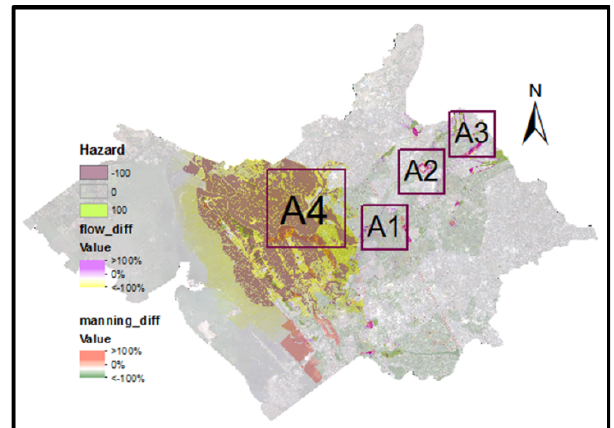
Figure 9. Locations of Areas of